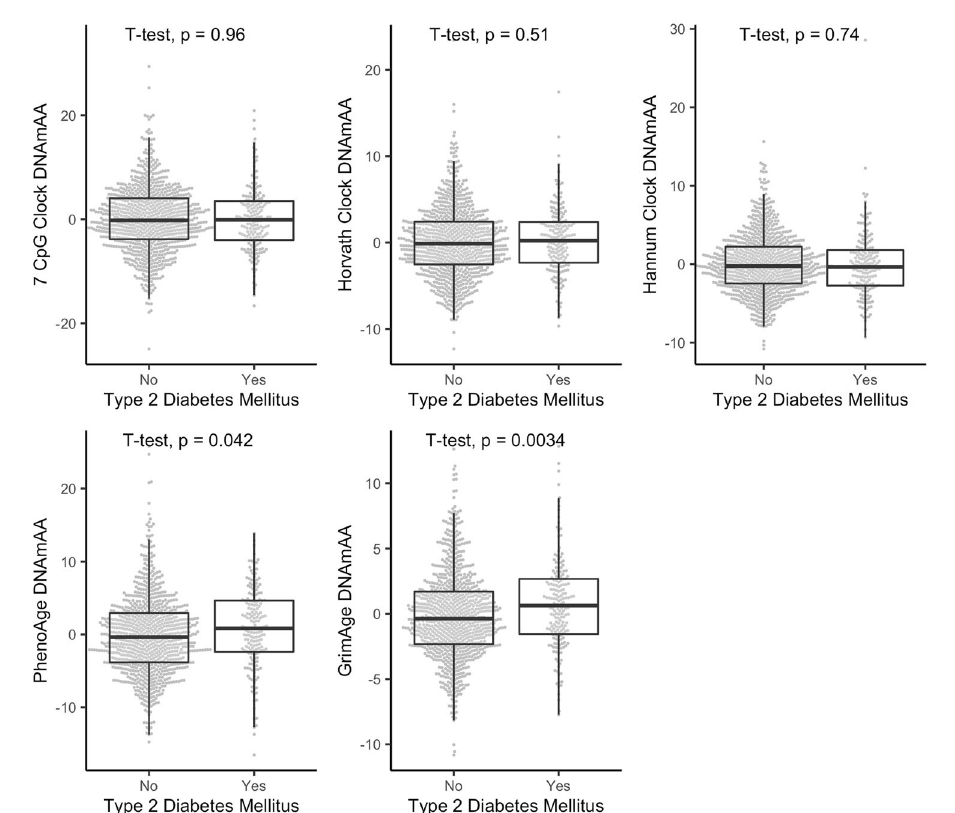
Fig. 1 Boxplots of DNAmAA estimates by fi ve different epigenetic clocks, strati fi ed by their diagnostic status (T2D vs. no T2D) at follow-up examination. Median, hinges (25th and 75th percentile) and Tukey-style whiskers (1.5* inter-quartile-range) are displayed. 7-CpG Clock DNAmAA: n = 1055; Horvath Clock DNAmAA, Hannum Clock DNAmAA, PhenoAge DNAmAA, GrimAge DNAmAA: n = 1051. Note: CpG = Cytosine phosphate guanine, DNAmAA = DNA methylation age acceleration. Table 3). However, none of the examined DNAmAA measures were associated with glycosylated hemoglobin (HbA1c, p > 0.2, Table 3). In sex-strati fi ed analyses, only the association between PhenoAge DNAmAA and oGTT in men remained statistically signi fi cant after covariate adjustment ( β = 0.96, SE = 0.39, Table 7). Additional to the longitudinally available 7-CpG clock, p = 0.014, n = 353, linear regression , Supplementary Table 6). four more epigenetic clocks were available at follow-up